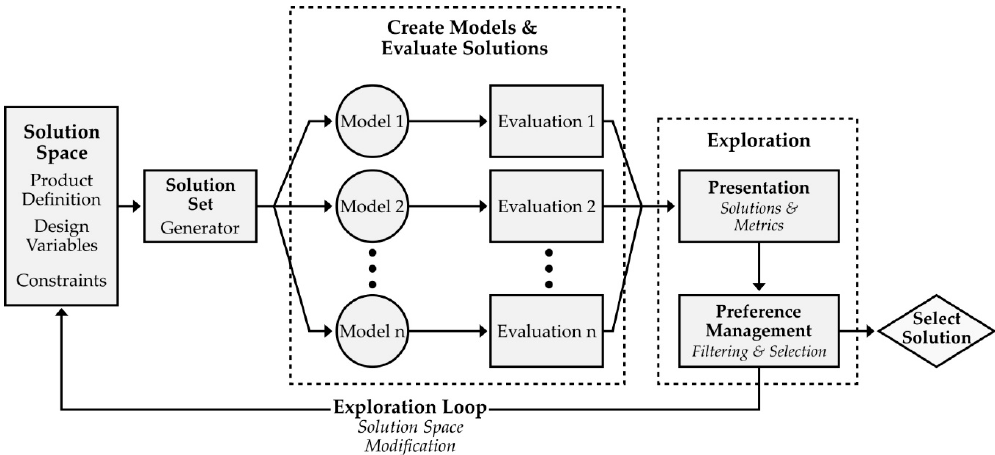
Figure 2. Overview of the developed framework for generative design.